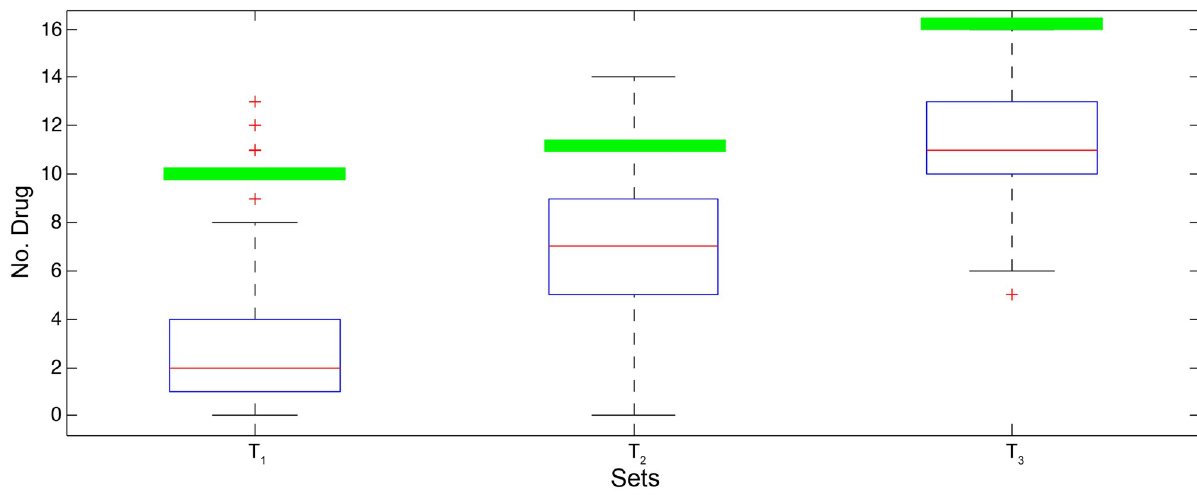
Fig 2. The boxplot of the results of the random sets for